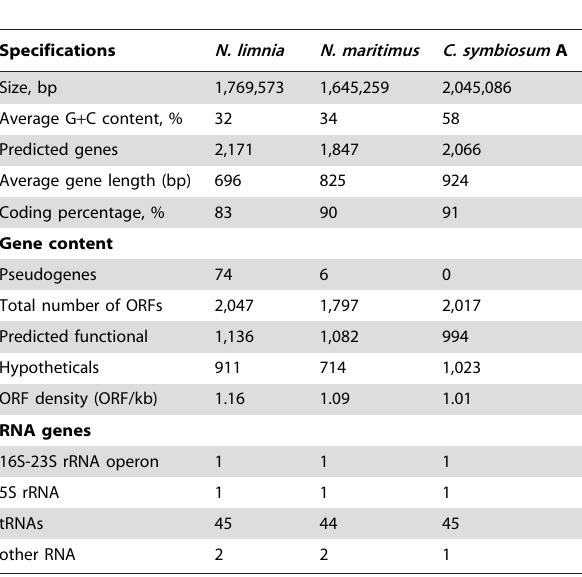
Table 2. Genome features for N. limnia , N. maritimus , and C. symbiosum